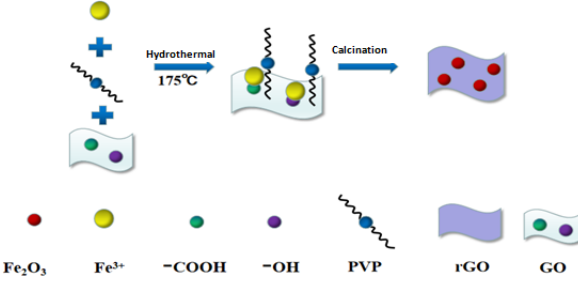
Figure 1: Schematic illustration of composites prepared by the PVP-assisted hydrothermal in-situ